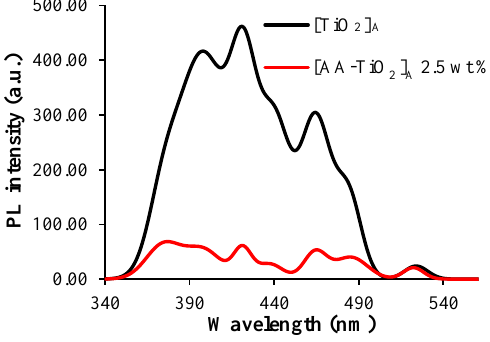
Figure 5. Photoluminescence (PL) spectra of [TiO 2 ] A (black line) and [AA-TiO 2 ] A with AA amount of 2.5 wt % (red line) excited at 290 nm in the wavelength range of 300 – 900 nm.